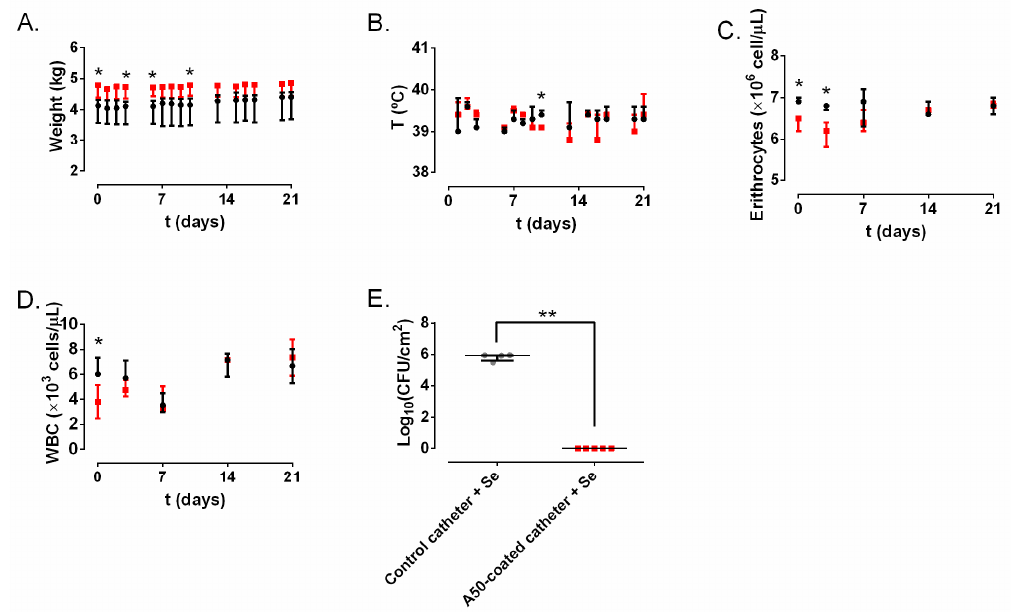
Figure 4. S. epidermidis (Se) infection model results of the control catheter group (black) and A50-coated catheter group (red) over time: weight ( A ); rectal temperature ( B ); erythrocytes ( C ); white blood cells (WBC) ( D ); and the quantity of bacteria per intraluminal area unit ( E ). *: p -value < 0.05, **: p -value < 0.01 for Wilcoxon test between the control catheter group and A50-coated catheter group.